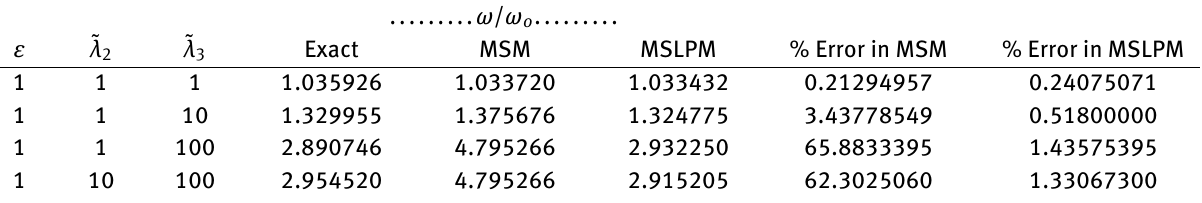
Table 4: Comparison of results of nonlinear frequency ratio when a 0 = 1